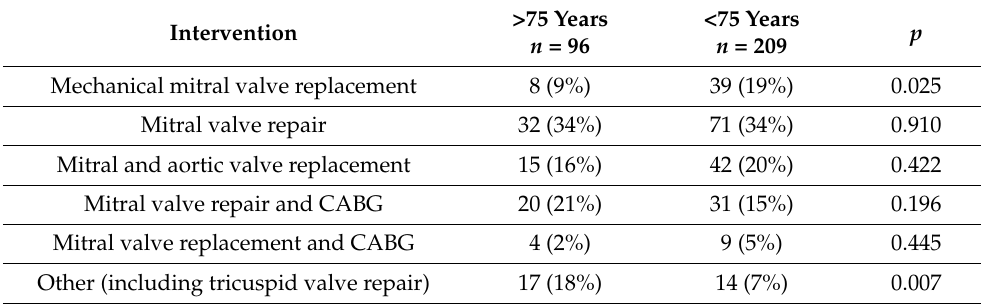
Table 3. Intervention performed.